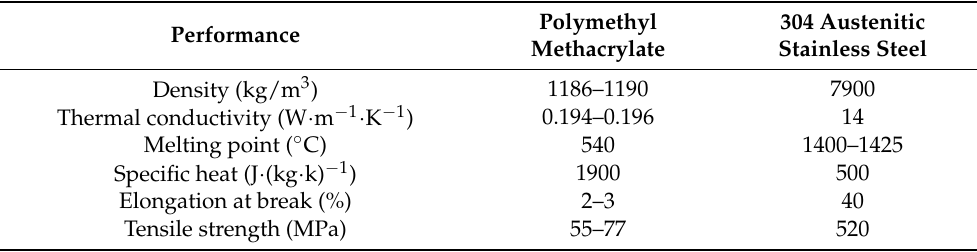
Table 1. Physical and mechanical properties of polymethyl methacrylate and 304 austenitic stainless steel